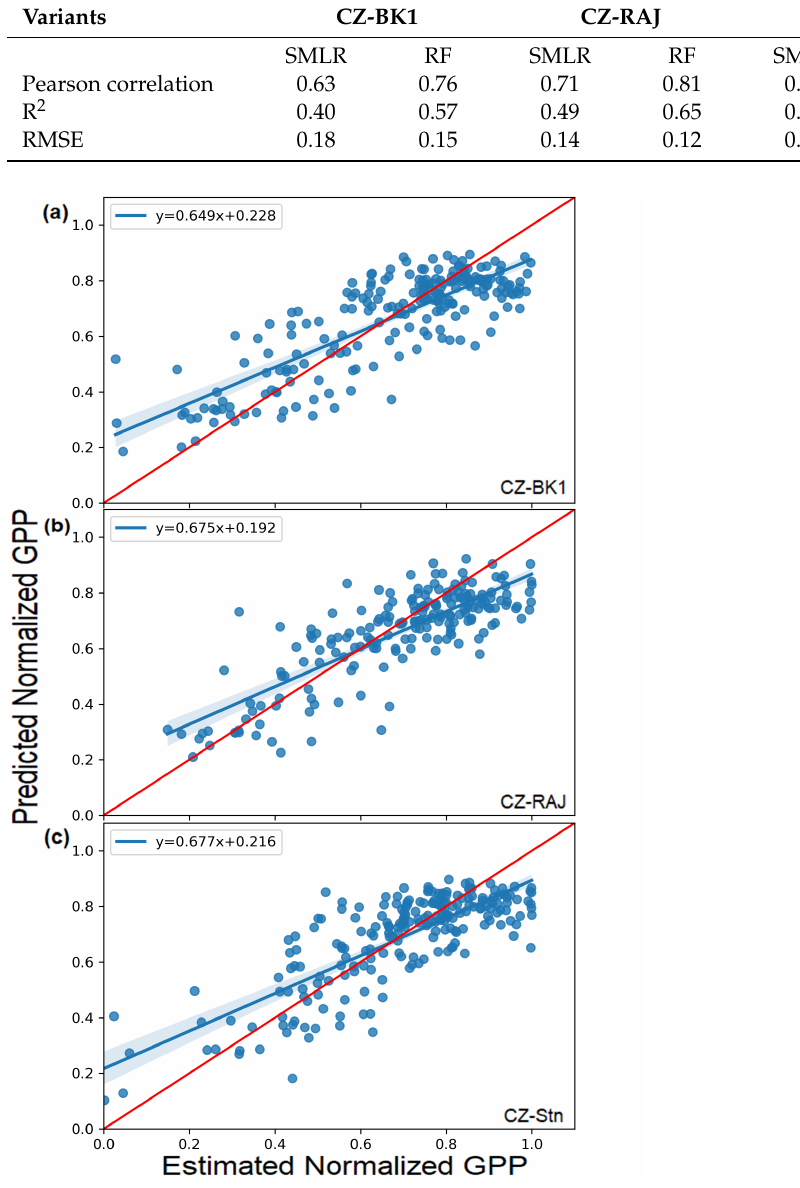
Figure 5. Comparison between estimated daily normalized gross primary productivity (GPP norm ) derived from eddy covariance measurements and predicted daily GPP norm estimated from the random forest (RF) analyses within ( a ) the wet spruce forest in Bílý K˘rí˘z (CZ-BK1), ( b ) the dry spruce forest in Rájec (CZ-RAJ), and ( c ) the beech forest in Štítná (CZ-Stn). 1:1 relationship between the predicted GPP norm and estimated GPP norm values from the RF are represented by the red line. The shaded blue area represent the 95% confidence